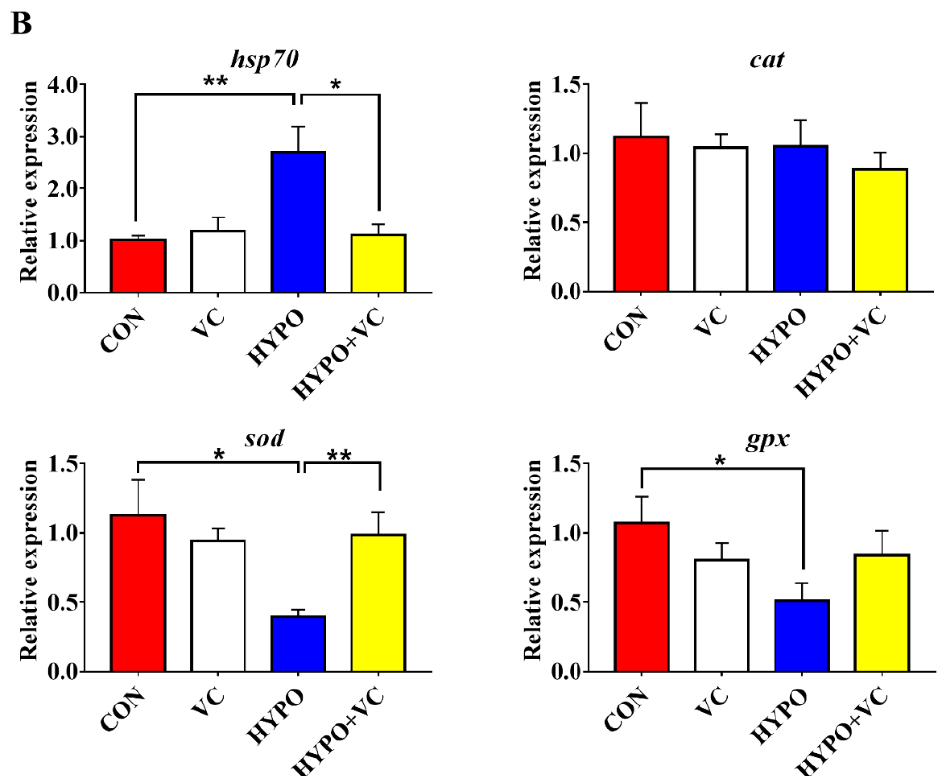
Figure 3. After 56 days of diet supplemented with VC, the expression levels of Nrf2 and Keap1 protein ( A ) and the expression of related genes ( B ) involved in antioxidant the Nrf2/Keap1 pathway in the liver of gibel carp were altered between the normal and hypoxia groups. The * or ** at the top of the bar chart indicate significant differences between treatments; * indicates a significant difference ( p < 0.05), and ** indicates an extremely significant difference ( p < 0.01). All of the data are presented as the mean ± standard error (n = 6). hsp70— heat shock protein 70; cat— catalase; sod— superoxide dismutase; gpx— glutathione